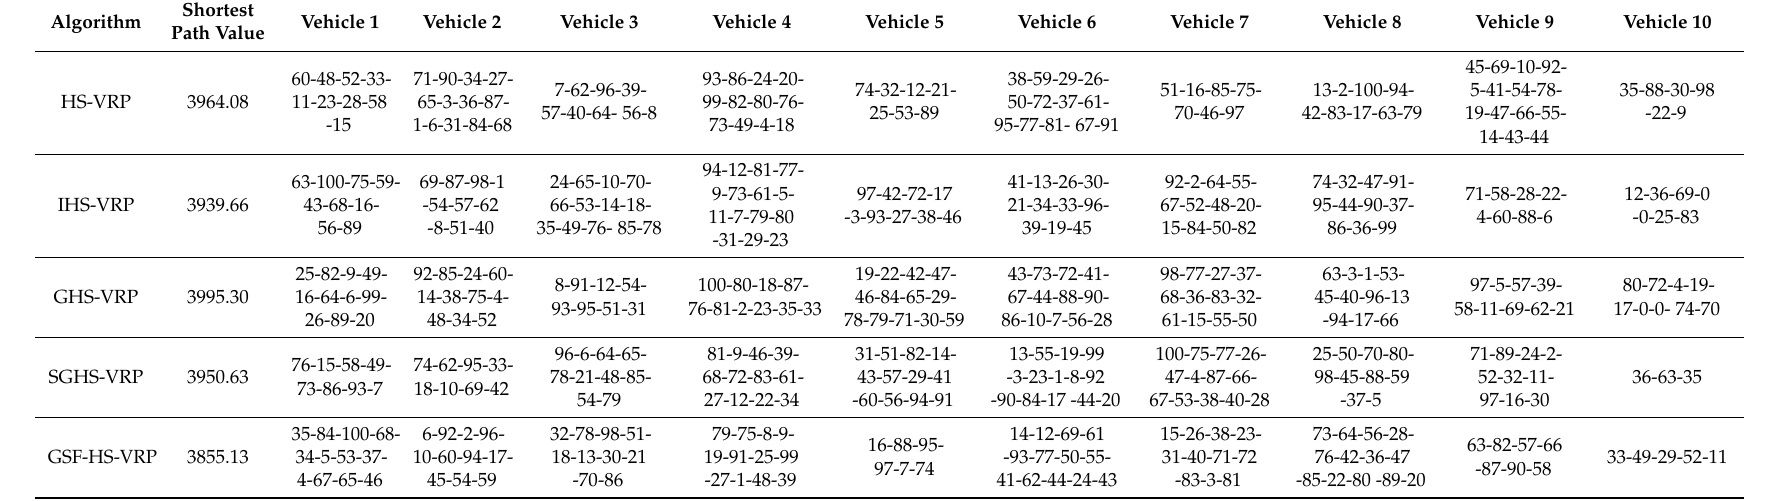
Table 9. Comparison optimization path results of the vehicle routing optimization of each